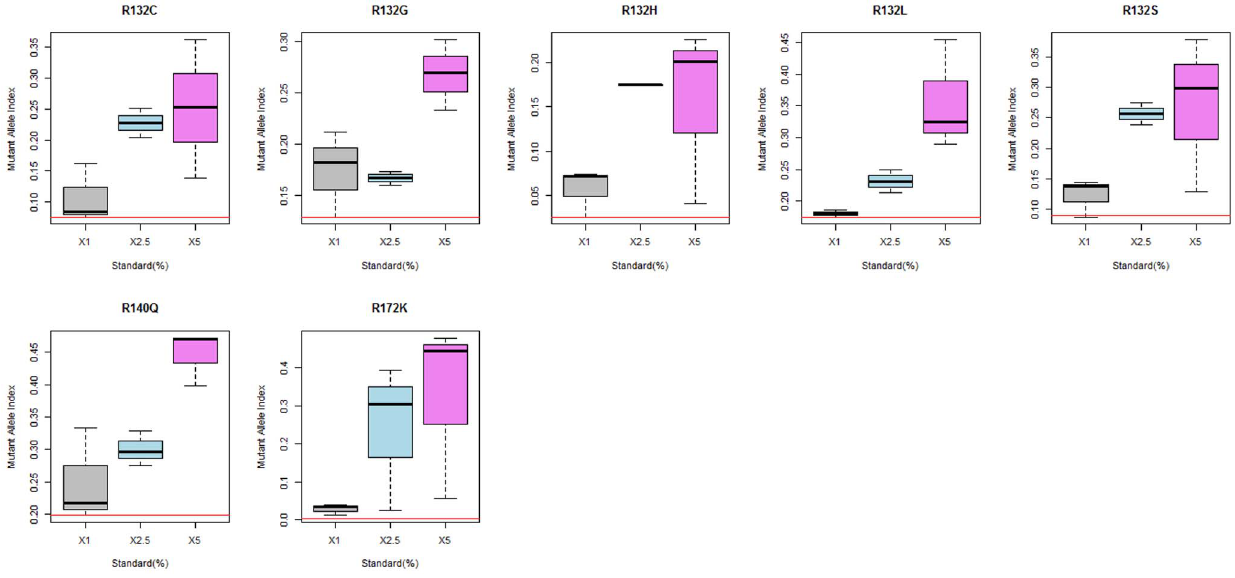
Figure 3. Graphical demonstration of the sensitivity of the assay for each mutant as expressed by percent mutant allele burden on wild type background. Data for the boxplots are from five independent experiments. The red lines denote the index cut-off values determined in the ROC analysis as described in the text.